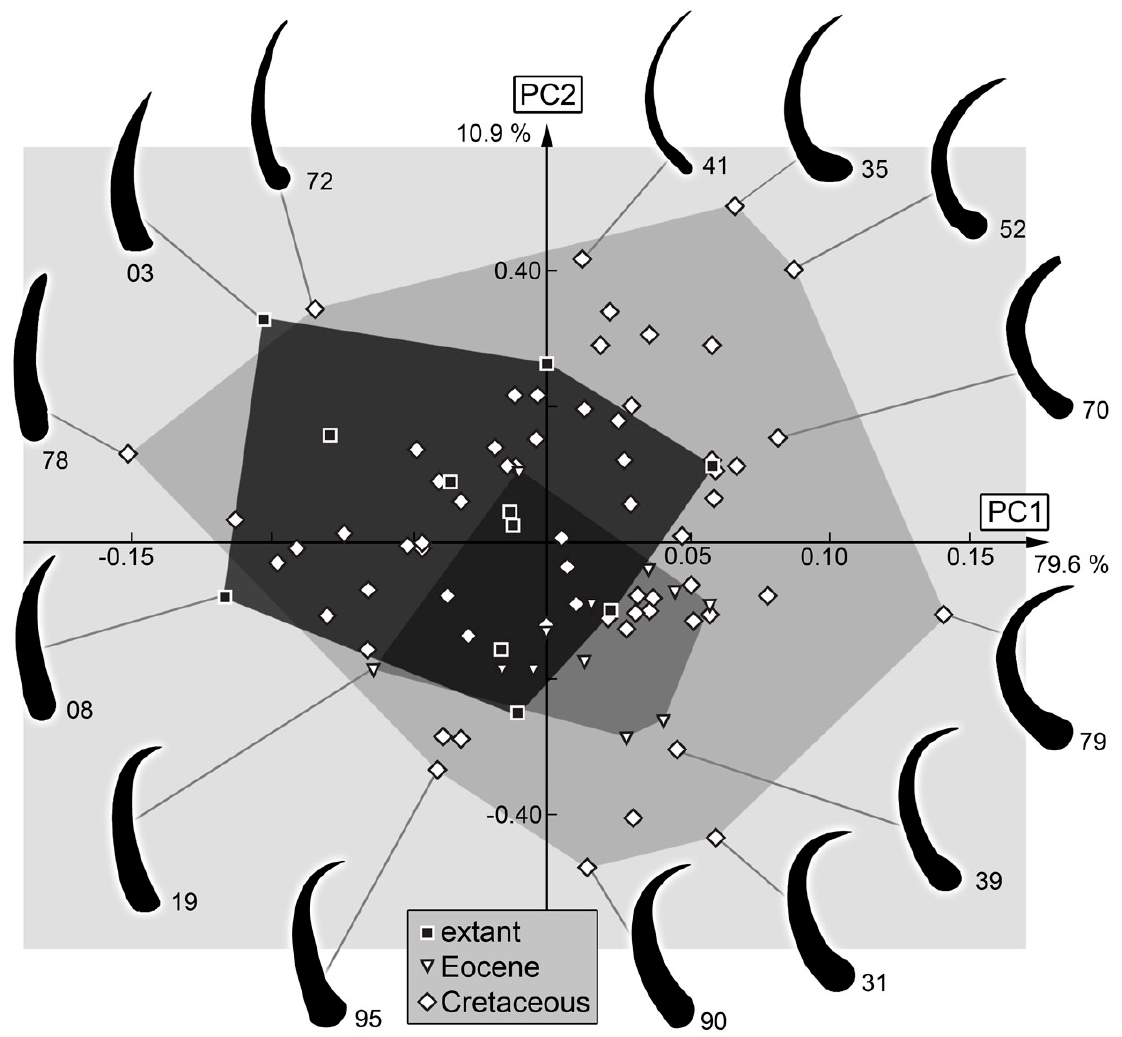
Figure 33. Scatterplot of PC2 vs. PC1 values of stylet shapes (see Supplementary Materials File S2 for details).